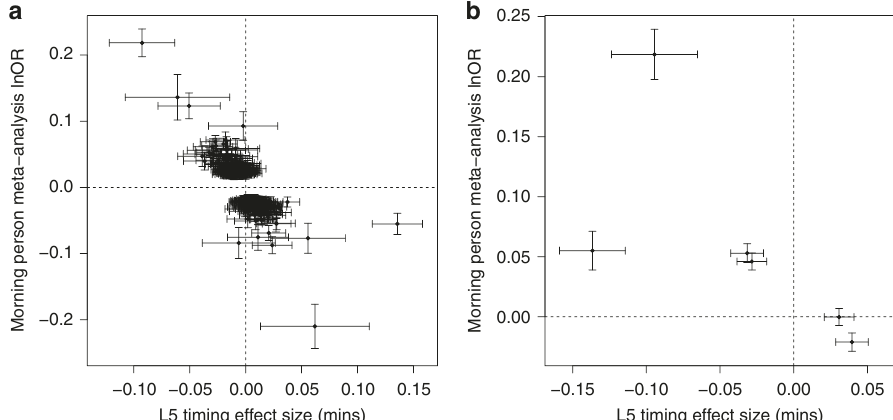
−0.10 −0.05 0.00 0.05 0.10 Fig. 4 Comparisons of genetic effect estimates on morning person (binary chronotype) and L5 timing. Plotted are the genetic effect estimates for variants associated with chronotype based on the latest self-report chronotype meta-analysis 31 against accelerometer-derived estimates of L5 timing: a Three- hundred fi fty-one variants identi fi ed from the self-report chronotype meta-analysis and b six variants identi fi ed for L5 timing. Error bars represent the 95% con fi dence intervals for each effect estimate. Chronotype effect estimates are reported for variants identi fi ed in the primary sample size meta-analysis using effect sizes (lnOR morningness) derived in the secondary effect size